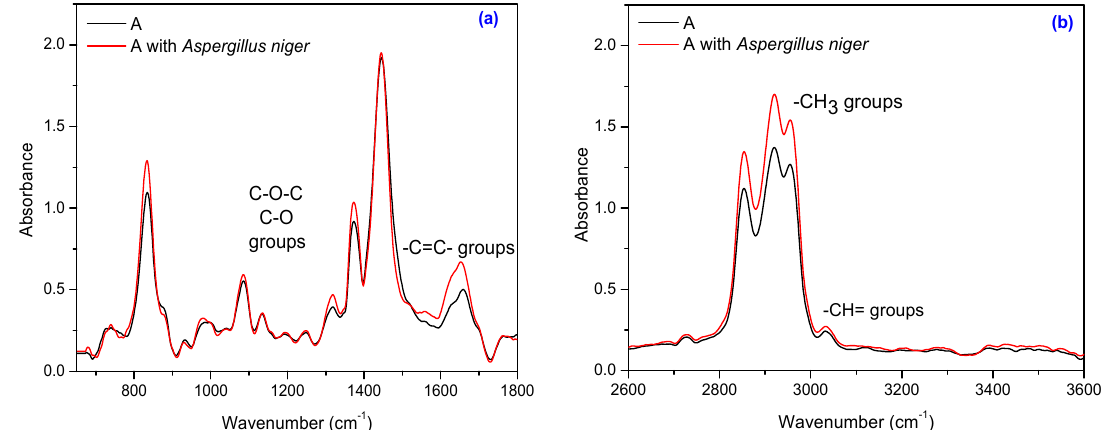
Figure 12. Infrared spectrum of the A sample: ( a ) in the range of 650–1800 cm − 1 and ( b ) in the range of 2600–3600 cm − 1 .